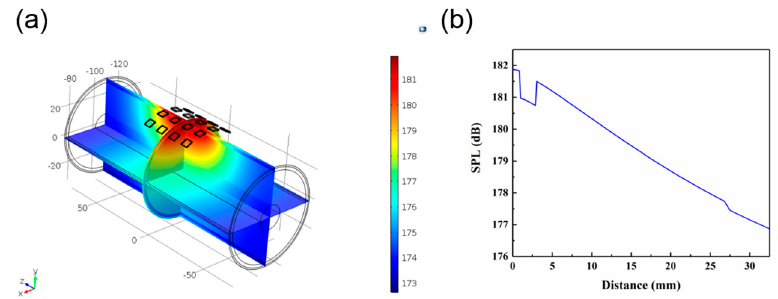
Table 2. Density and thickness of different tissues.